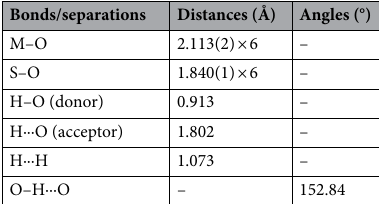
Table 4. Selected interatomic distances and angles.